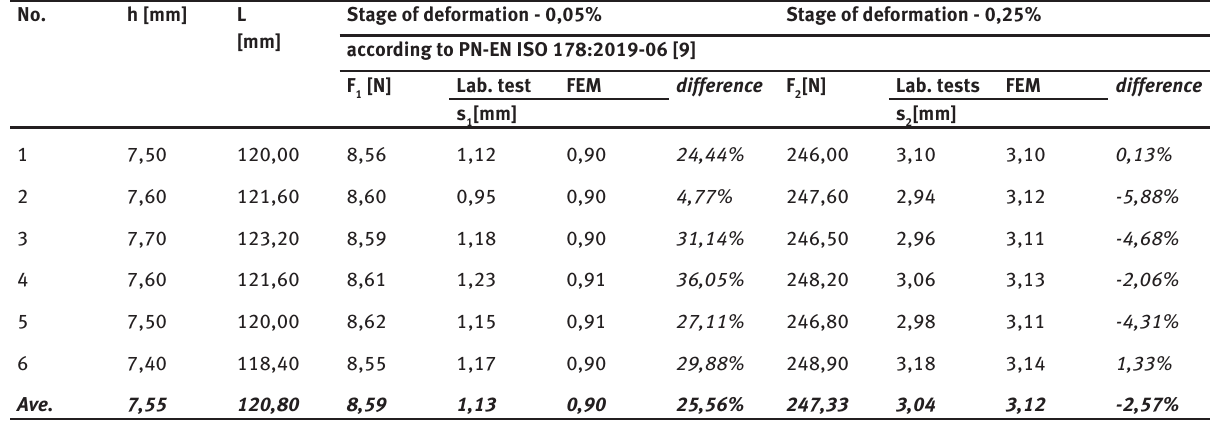
Table 8: Comparison of results of numerical analyses and laboratory tests for a model of a liner with a diameter of 350mm and 7,50mm wall thickness.